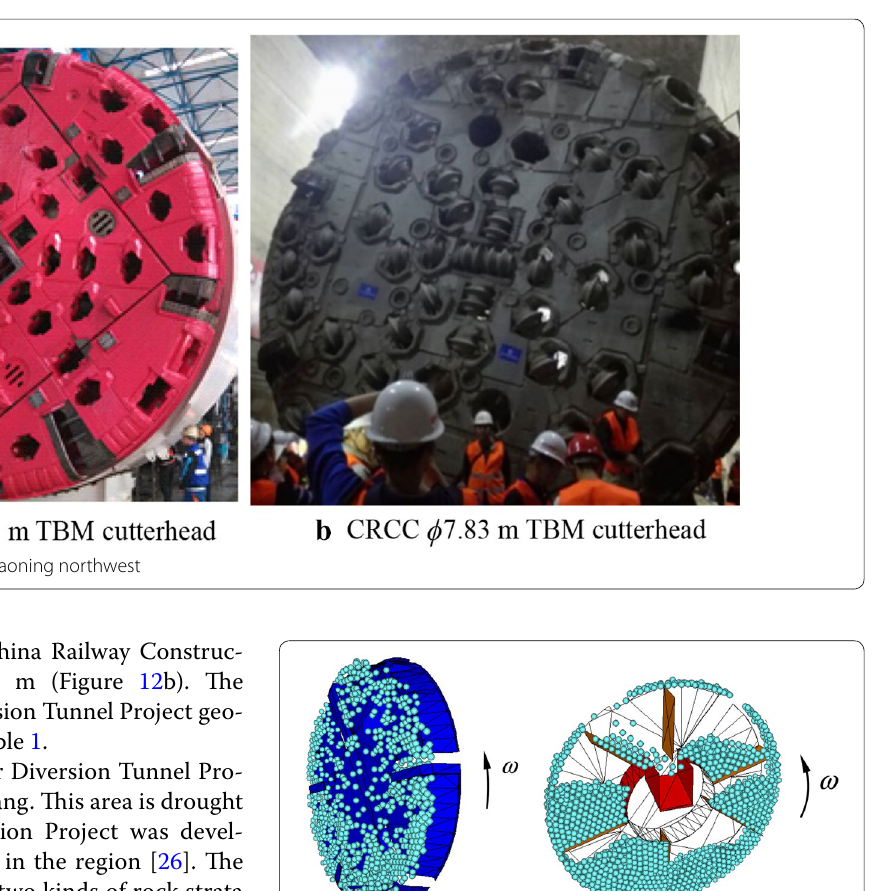
Figure 13 Discrete element simulation of TBM cutter